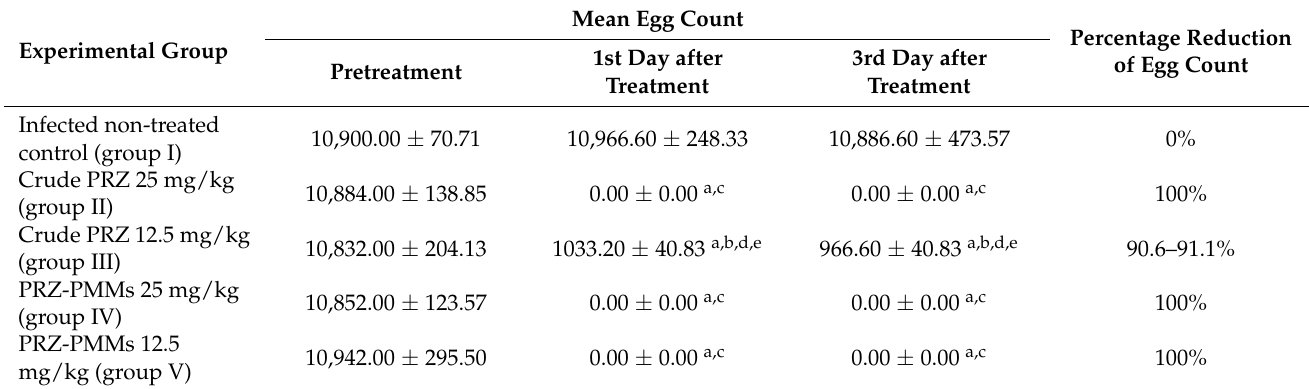
Table 7. Mean egg count and percentages of reduction among the different groups.